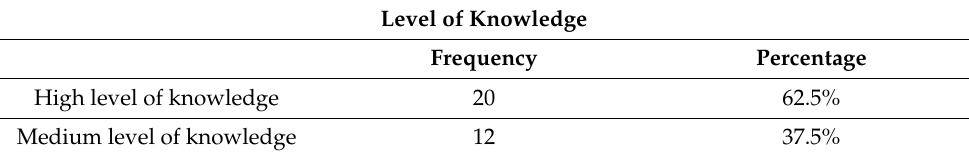
Table 2. Tutor ´ s Knowledge Level and Percentage.